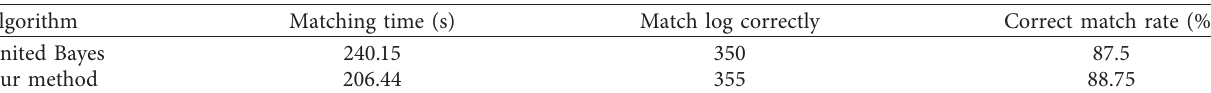
Table 9: Comparison of total recognition rates of facial features of different